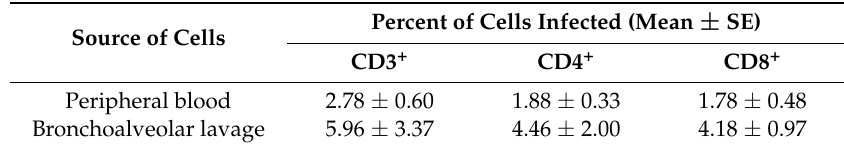
Table 1. Percent of influenza virus-infected lymphocytes or lymphocyte subpopulations determined by internalization of FITC-labeled influenza